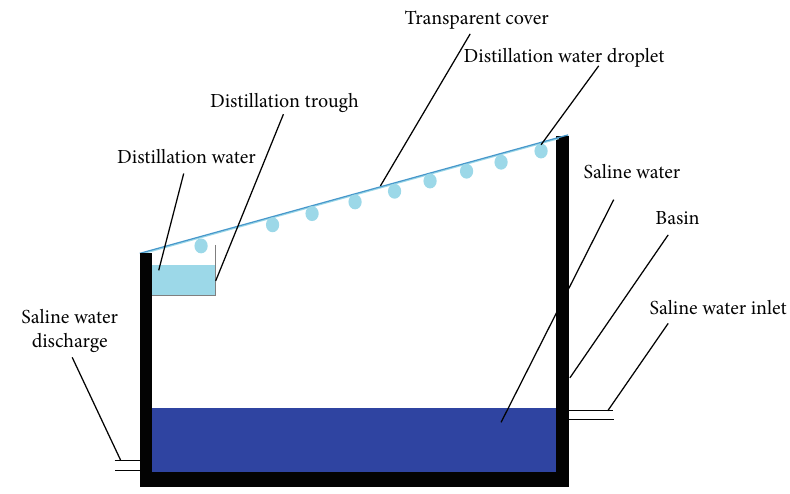
Figure 8: A schematic view of a simple solar still